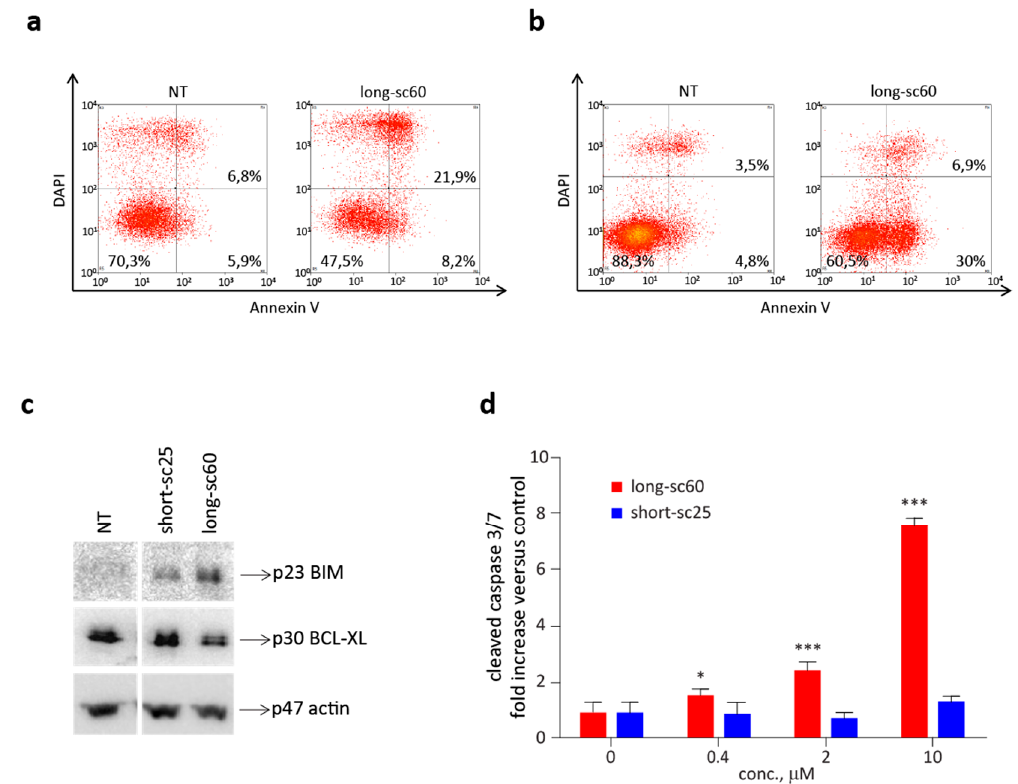
Figure 5. Long-sc60 induces apoptosis in MET-addicted cancer cells. Flow cytometry analysis of MET- addicted ( a ) SNU-5 or ( b ) EBC-1 cells treated with long-sc60 (0.5 µM) for 48 h and then stained